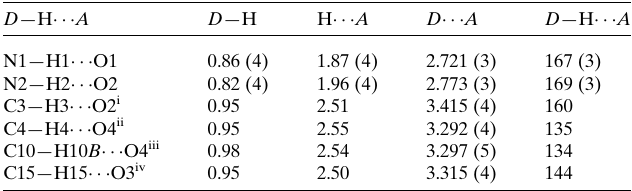
Table 1 Hydrogen-bond geometry (A˚ , (cid:4) ) for (I).